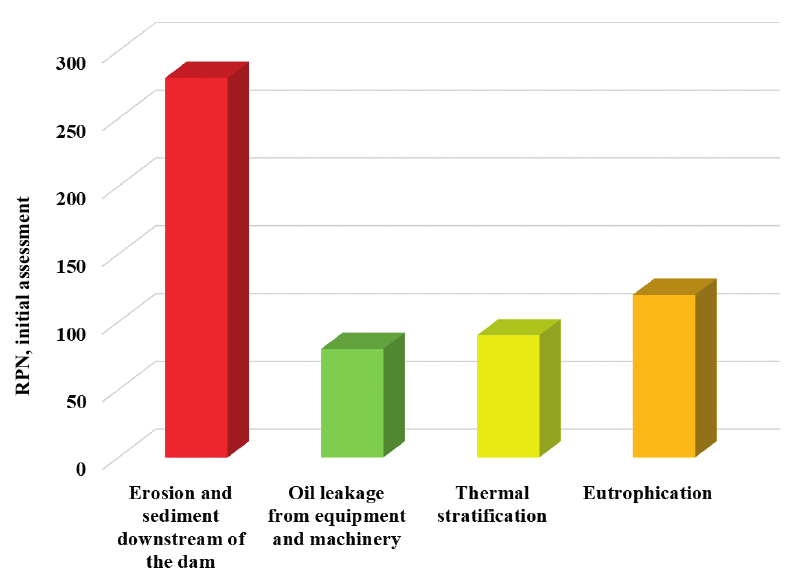
Fig. 5. Risk level assessment in the utilization